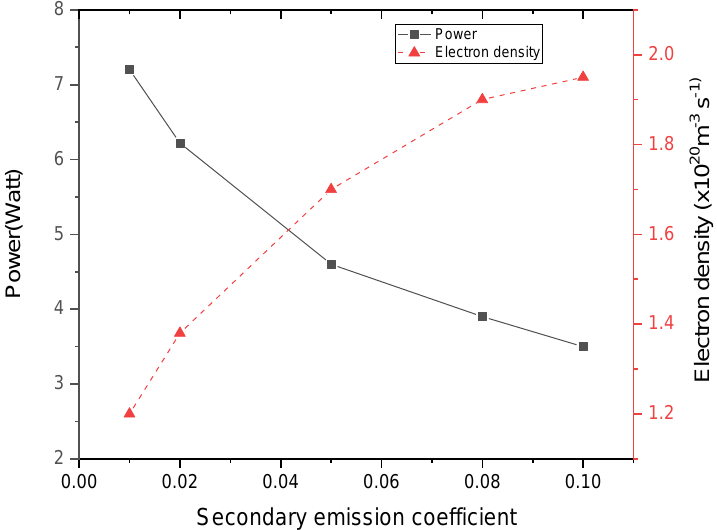
Figure 9. Evolution of electron number density N e and consumed power P with different secondary emission coefficients.